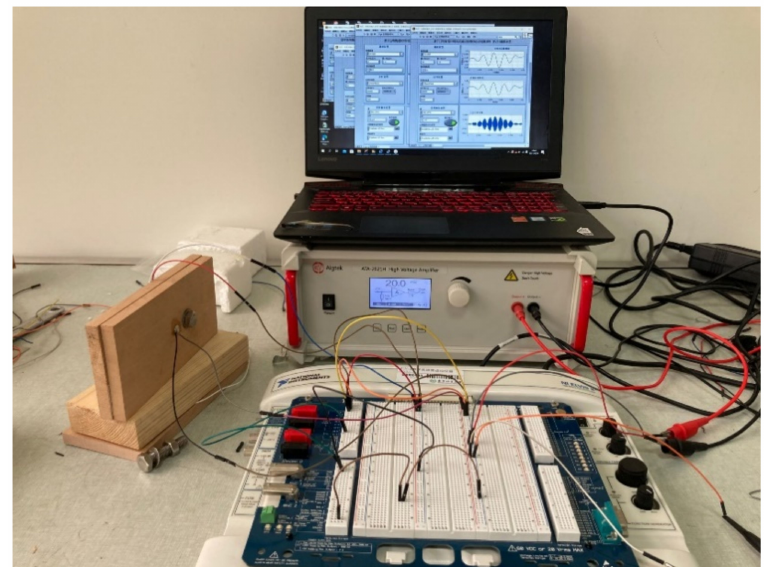
Figure 1. Experimental